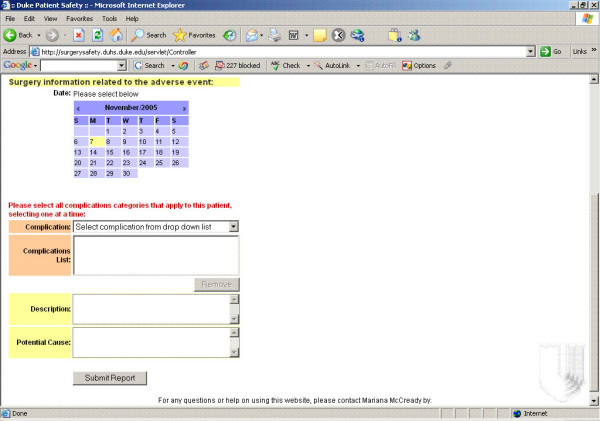
Complication Report.